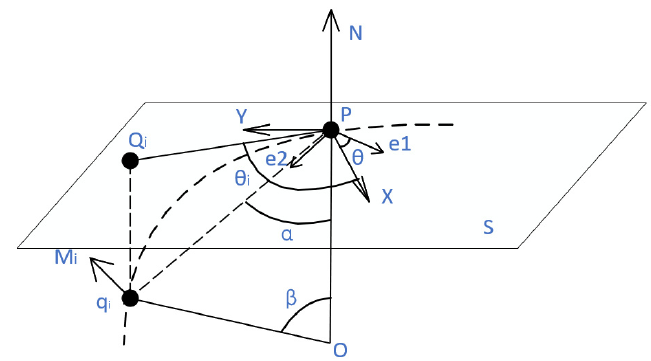
Figure 3. Local coordinate system